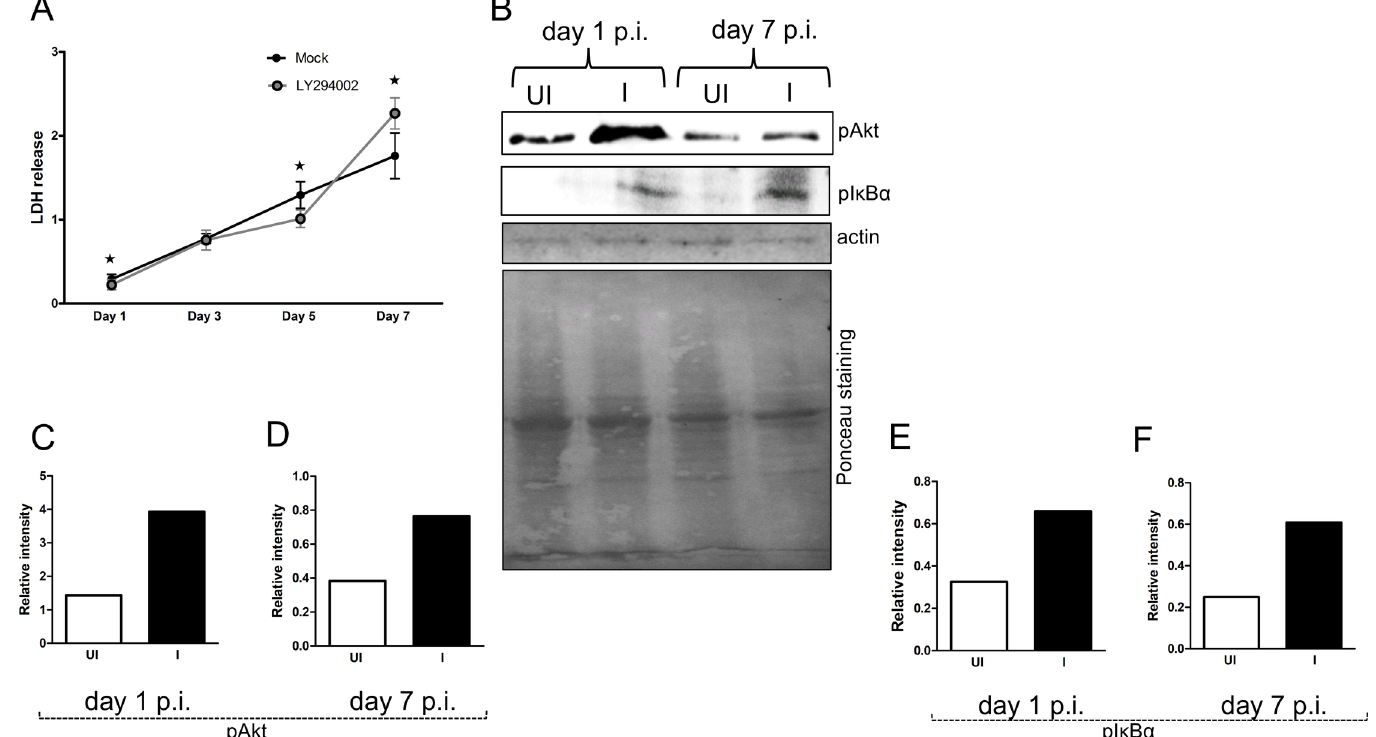
Fig 5. A . phagocytophilum infection increasesAkt and NF- κ B activation in MEG-01 cells. ( A) LDH assay results performed with cell culture supernatants collectedfrom A . phagocytophilum -infected mock-treated (mock) or A . phagocytophilum -infected LY294002(PI3K inhibitor)-treated at different days (1, 3, 5, 7) p.i is shown. Valueson the Y-axis show the absorbancefor LDH release in the cell culture supernatants. The results are from three independentexperiments performed in triplicates. All cultures were started simultaneously at the same time. The culture medium was not changeddaily. The P value (P < 0.05)calculatedfrom Student’s t test was consideredsignificant.(B) Immunoblotting analysisshowinglevels of phosphorylated Akt and I κ B alpha in uninfected(UI) or A . phagocytophilum -infected (I) MEG-01 cells at days 1 and 7 p.i. The levels of actin (detectedby immunoblotting) and Ponceaustained gel image for total protein serves as loadingcontrol. Densitometry analysisshowinglevels of Akt (C and D) or I κ B alpha (E and F) at days 1 (C and E) and 7 (D and F) p.i., relativeto the respectiveactin bands seen in B.